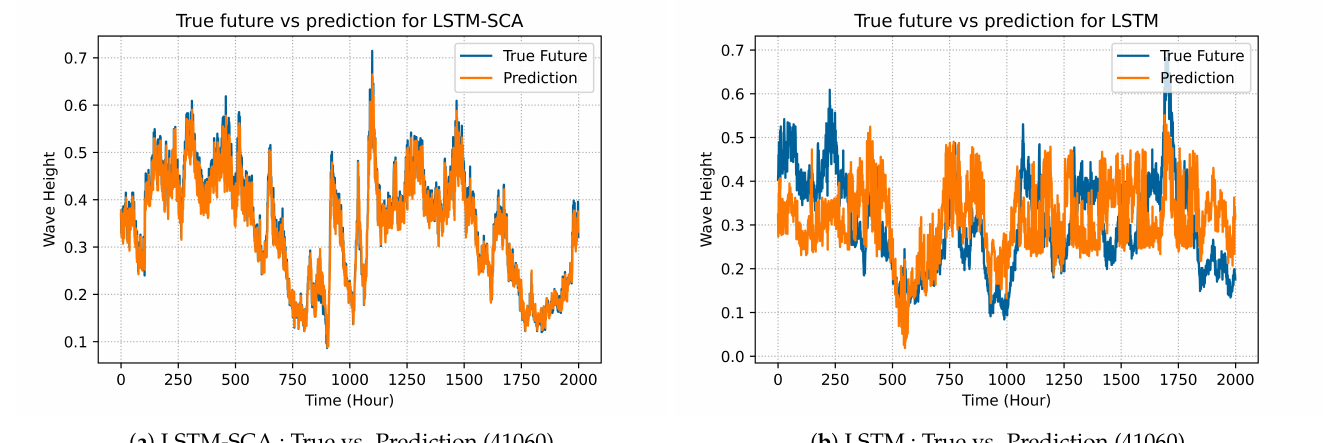
Figure 12. Comparison of VRNN models on dataset 41060.